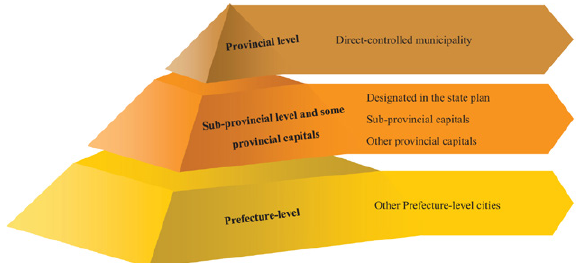
Figure 5. The power pyramid structure of the Chinese